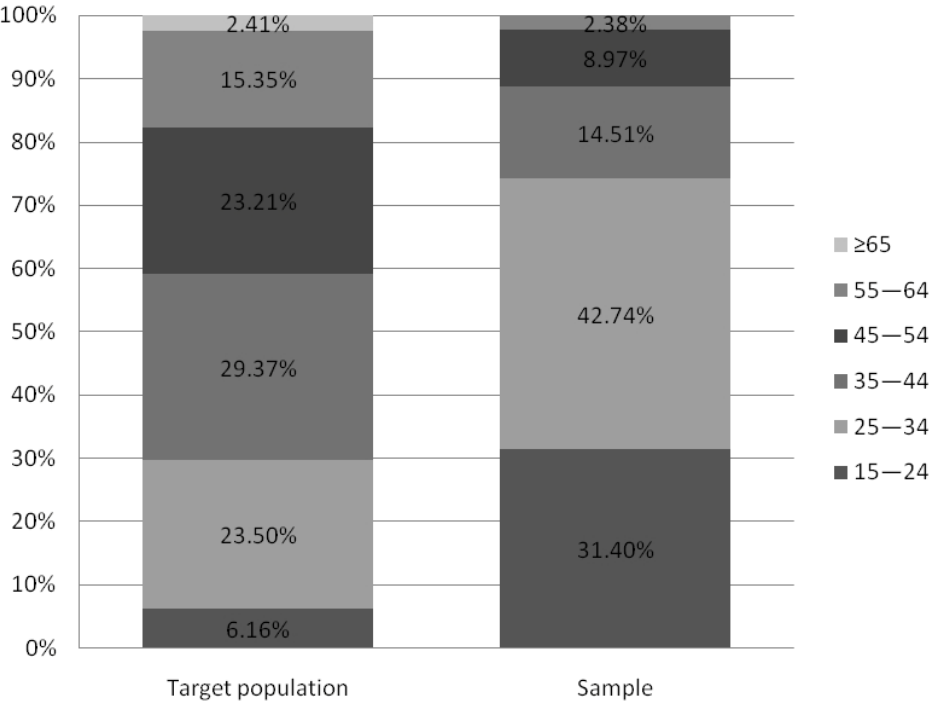
Figure 6. Age distribution in the target population and the study sample (based on Statistic Poland). Note. Status report on target Polish working population in the 4th quarter of 2020 according to “Yearbook of Labour Statistics 2021”; Statistics Poland.